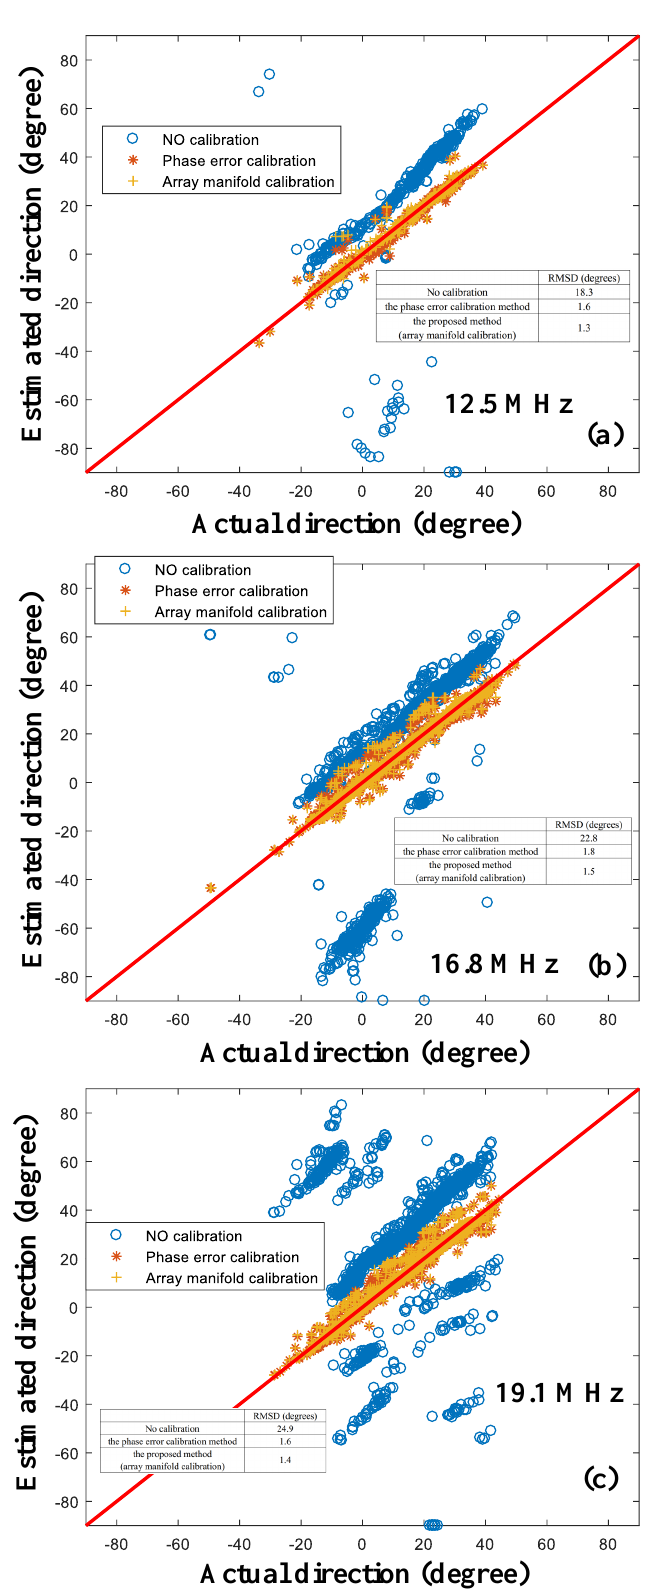
Figure 9. Scatter plot of the ship direction estimation using three data calibration strategies: no calibration, phase error calibration, and array manifold calibration. ( a ) 12.5 MHz; ( b ) 16.8 MHz; and, ( c ) 19.1